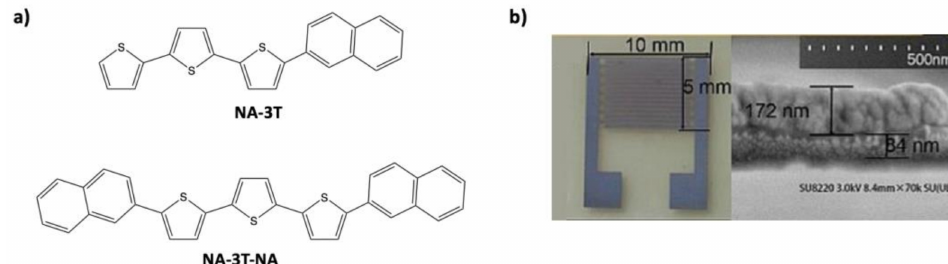
Figure 3. ( a ) Molecular structures of the naphthalene-functionalized terthiophenes synthesized for detection of biogenic amines. ( b ) Left: top view of the sensor device based on a silver/terthiophene derivative thin film. Right: SEM cross-sectional image of the silver/terthiophene derivative thin film deposited on glass substrate. Adapted with permission from ref. [523] Copyright 2019 Wiley-VCH Verlag GmbH & Co. KGaA,